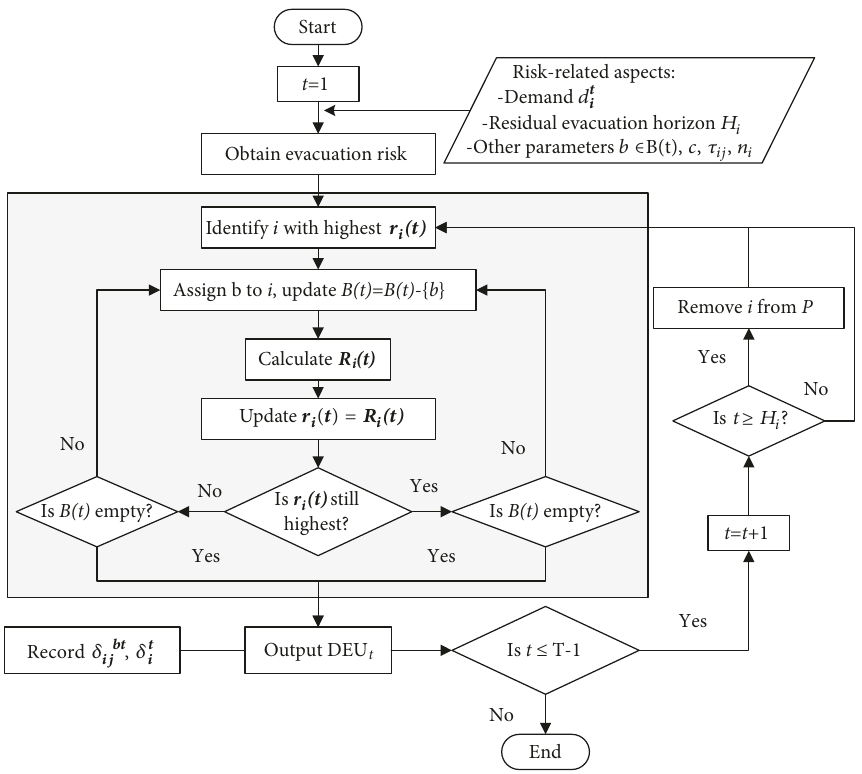
Figure 2: Time-dependent framework of bus schedule scheme for bus-based evacuation with DEU-based